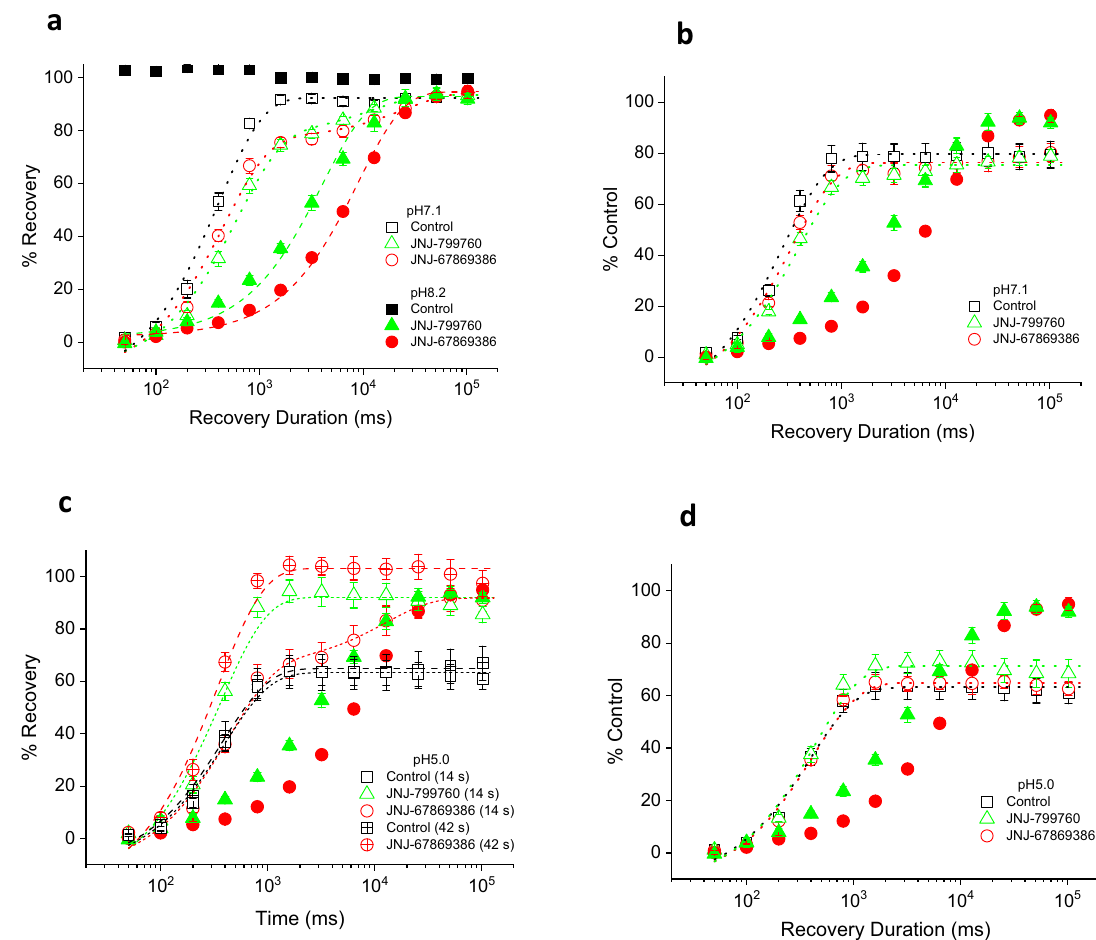
Fig. 5 Effect of JNJ-799760 and JNJ-67869386 on the kinetics of compound-free recovery from desensitization. a Recovery from pH 7.1-induced- desensitization (open symbols) or from inhibition at pH 8.2 (solid circles and triangles) by JNJ-67869386 and JNJ-799760 (both 100 nM). Compound (except pH 8.2 control, solid squares) is present only prior to recovery. Recovery τ = 402.2 ± 34.7 ms, 450.5 ± 57.5 ms/25.1 ± 17.9 s (18.8%), 598.0± 75.0